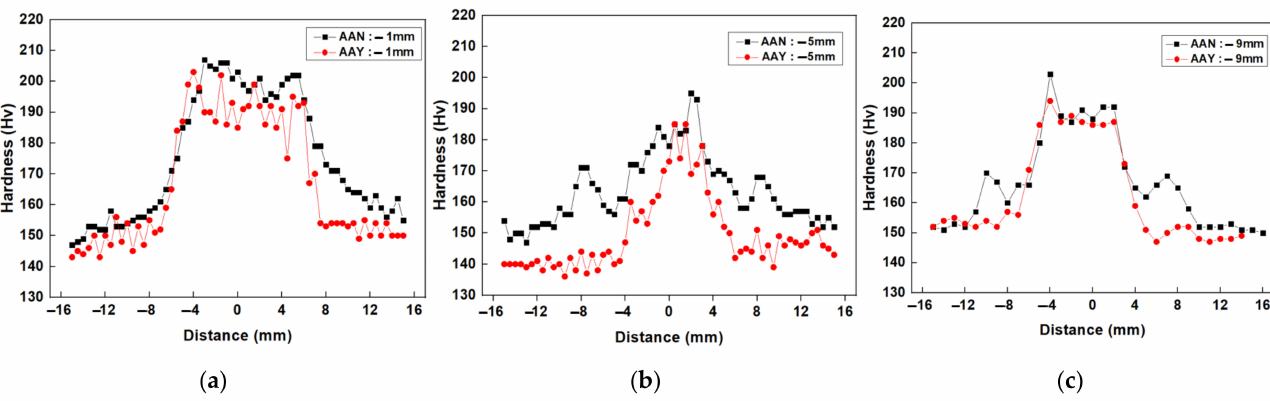
Figure 17. Micro hardness distribution, AAN: non PWHT, AAY: PWHT at 590 ◦ C. ( a ) − 1 mm deep; ( b ) − 5 mm; and ( c ) − 9